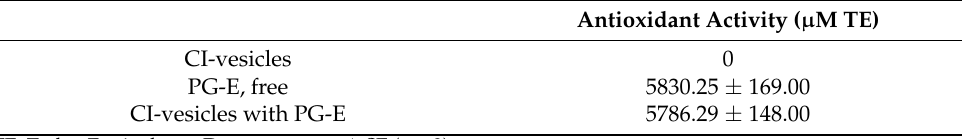
Table 4. Antioxidant activity ( µ M TE) of cauliflower inflorescence vesicles (CI-vesicles) and pomegranate extract (PG-E), free or encapsulated in CI-vesicles.